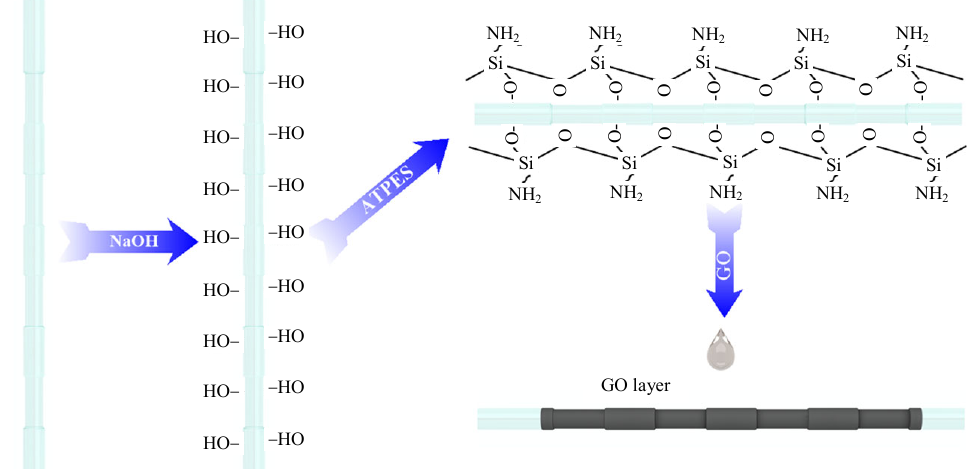
Fig. 1 Schematic diagram of the fabrication process of the GMLPG.